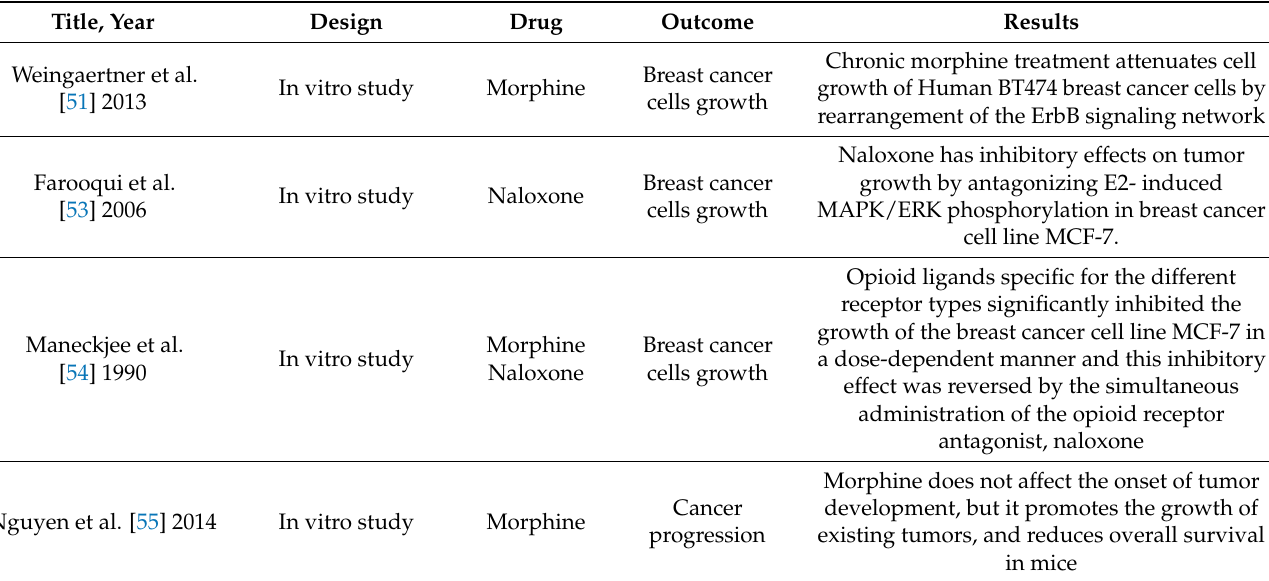
Table 4. Opioids and tumor growth. Selected preclinical and clinical studies. ErbB: epidermal growth factor receptor; MCF-7: Michigan Cancer